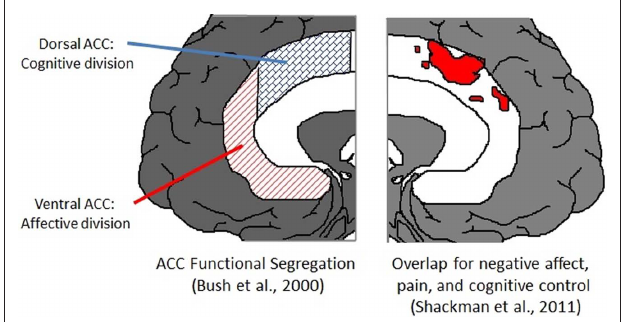
Figure 3 | Views on the psychological function of ACC. Left: ACC function has been suggested as anatomically segregated into a dorsal cognitive division and a ventral affective division (Bush et al., 2000). Right: more than a decade later, a meta-analysis on almost 200 fMRI experiments suggested a strong overlap in clusters of activation in studies of cognitive control, negative affect, and pain (Shackman et al., 2011). Figures adapted from Shackman et al.